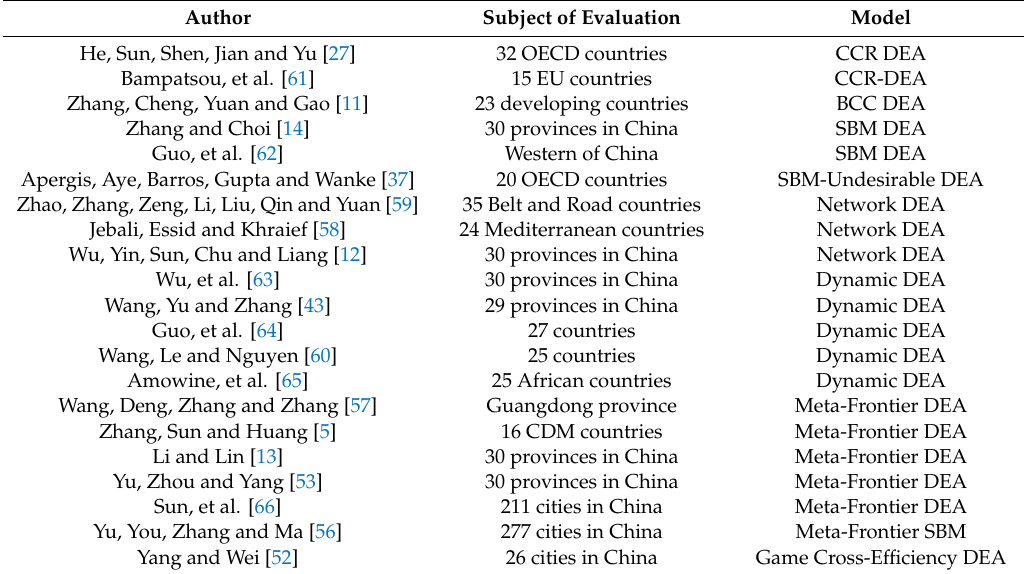
Table 2. Energy e ffi ciency evaluation of